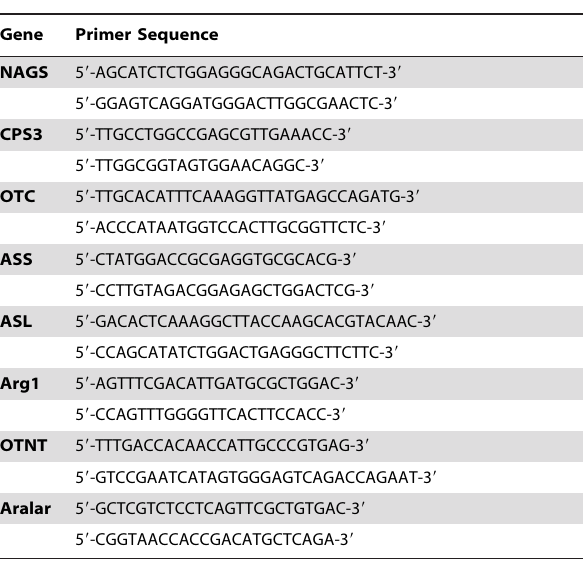
Table 3. Primers that were used for quantitative RT-PCR of urea cycle genes in the developing